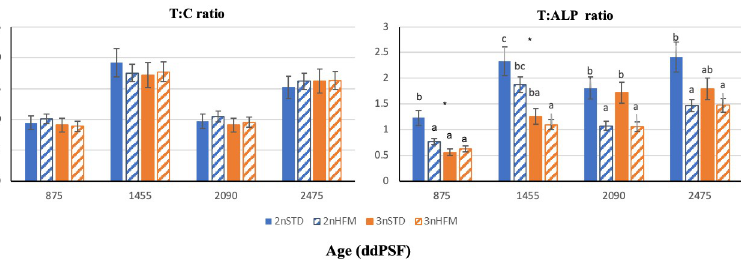
Fig 10. Trypsin and chymotrypsin ratio (T:C) and trypsin and ALP ratio (T:ALP) of diploid (2n) and triploid (3n) Atlantic salmon, Salmo salar , fed fish meal (STD) and hydrolysed fish protein (HFM) diets at 875, 1455, 2090 and 2745 ddPSF sampling (see Table 1). Data are presented as means ± SE (n = 15). Different lower case letters denote significant differences (P < 0.05) between groups. ( � ) Indicates significant differences between 2n and 3n in each sampling (P < 0.05). Data are presented as means ± SE (n = 15).